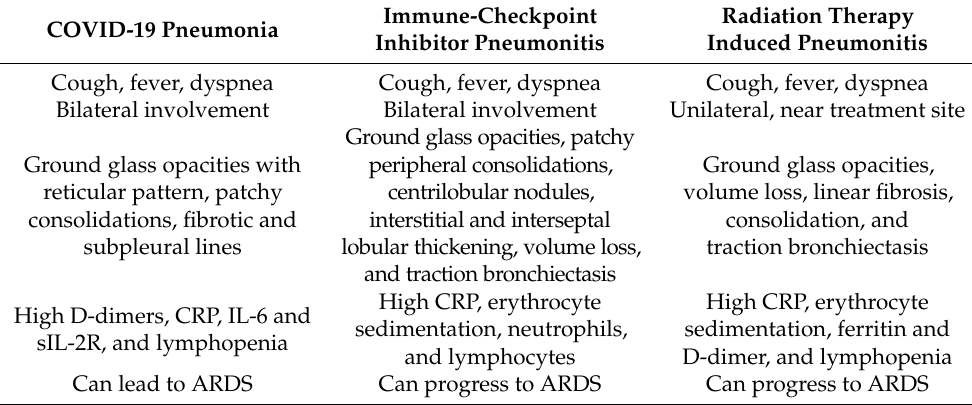
Table 3. Clinical and radiographic findings of COVID-19 pneumonia, immune-checkpoint pneumoni- tis, and radiation